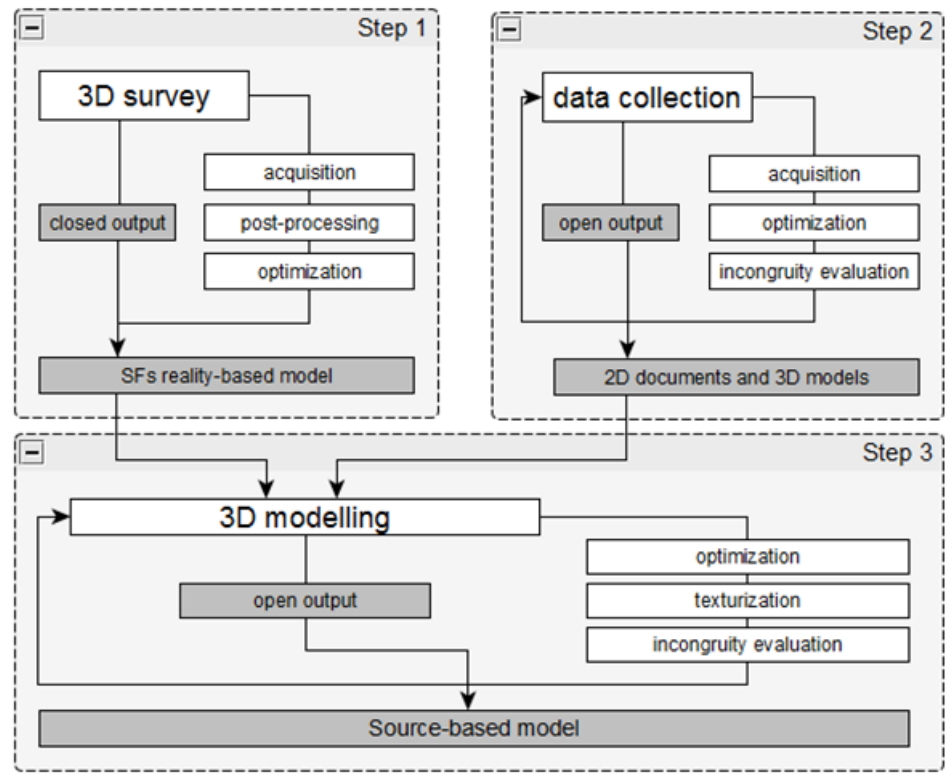
Figure 5. Virtual sculptural reconstruction workflow .